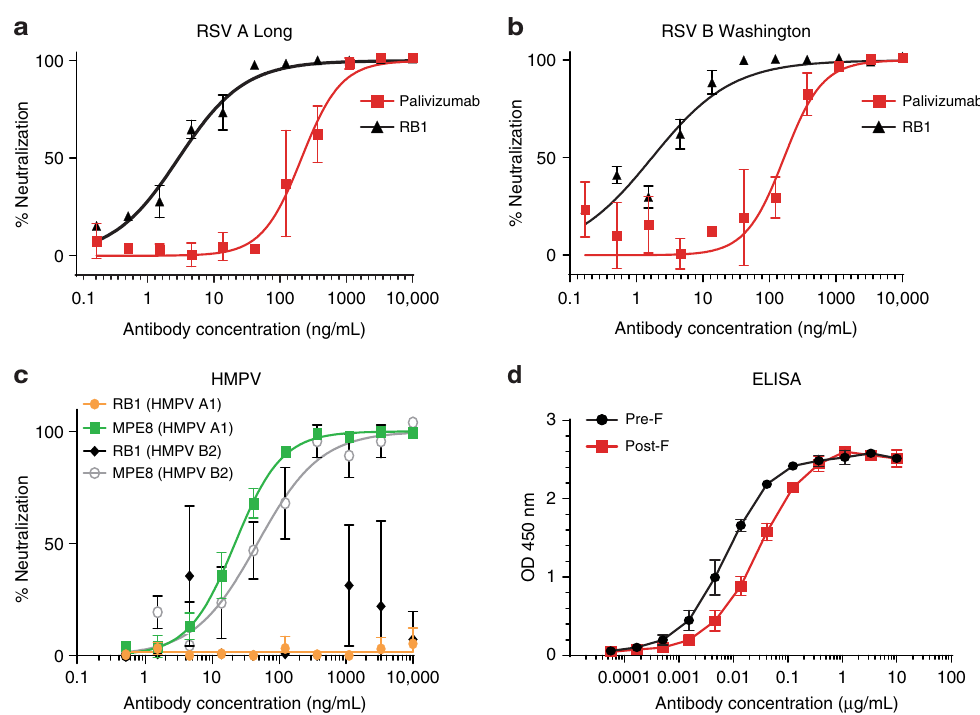
Fig. 1 In vitro binding and neutralization. a The neutralization activity of RB1 against laboratory strains RSV A (Long) and b RSV B (Washington) with palivizumab as an assay control antibody. Assays were run in duplicate, showing error bars at mean with standard deviation (SD). An IC 50 was calculated using a log versus response variable slope 4 parameter fi t curve and represents the concentration of antibody required for a 50% reduction in the RSV infectivity in a microneutralization assay. c The neutralization activity of RB1 against laboratory strains HMPV A and B with MPE8 control antibody. Assays were run in triplicate, showing error bars at mean with standard deviation (SD). An IC 50 was calculated using a log versus response variable slope 4 parameter fi t curve and represents the concentration of antibody required for a 50% reduction in the HMPV infectivity in a microneutralization assay. d The enzyme-linked immunoassay (ELISA) binding curves of RB1 binding to the pre-F and post-F protein conformations. The assay was run in duplicate showing error bars at mean with SD. An EC 50 was calculated and represents the concentration of antibody required for a 50% reduction in binding. Source data provided as a source data fi le